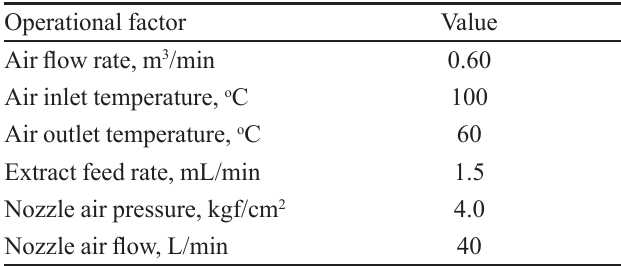
TABLE I - Summary of operational conditions during spray drying of extracts Operational factor